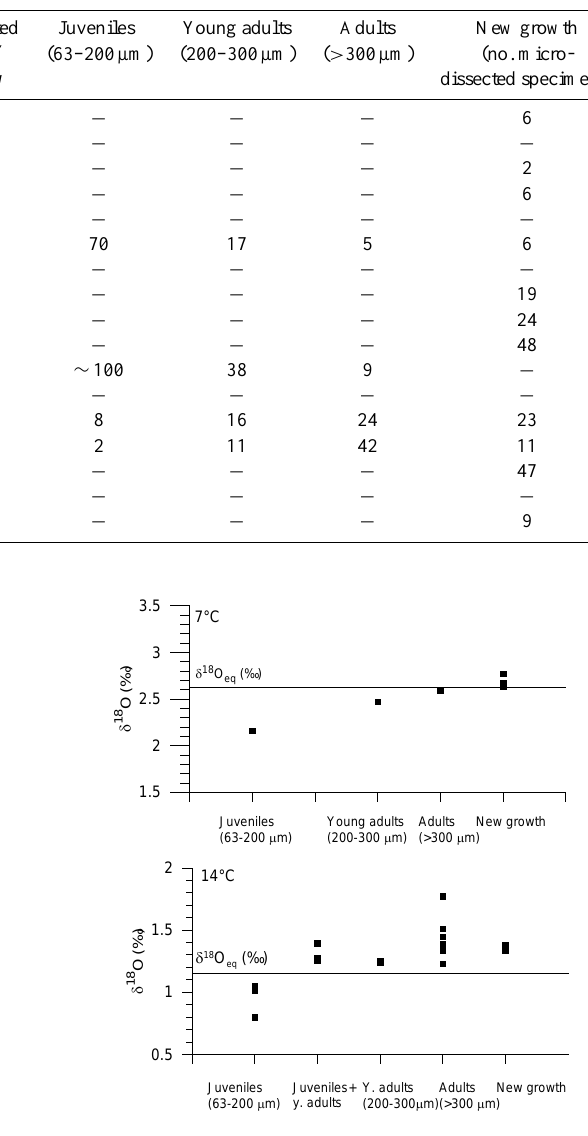
Fig. 4. The uppermost panel (a) shows δ 18 O values at 7 ◦ C and the lower panel (b) for 14 ◦ C for the different size classes, together with the equilibrium calcite line for each